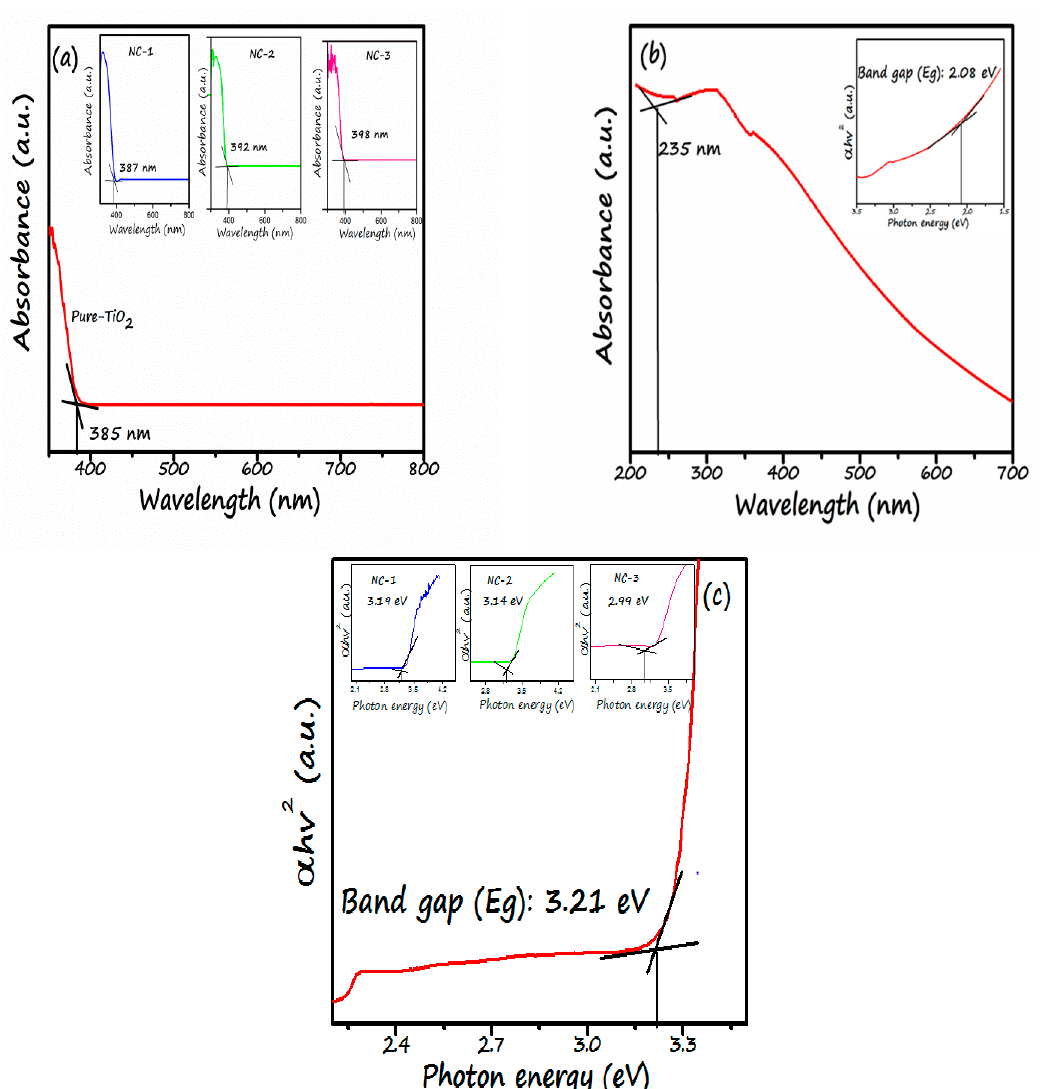
Figure 6. DRS spectra of ( a ) Absorption edge of Bare TiO 2 (insets shows the zoom-in plot showing absorption edge of TiO 2 in NC-1, NC-2 and, NC-3) ( b ) Absorption edge of GO (inset shows the Bandgap of GO), ( c ) Bandgap of bare TiO 2 (insets shows the zoom-in plot showing band gap of TiO 2 in NC-1, NC-2 and, NC-3). The bandgap of all the samples was calculated using the tauc equation: α hv = A(hv − Eg) 2 [24]. By plotting graph between ( α hv) 2 against hv. The band gap value of